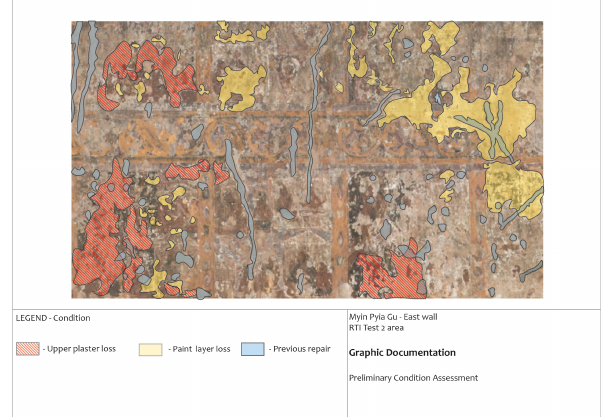
Figure 6. Graphic documentation of an area in